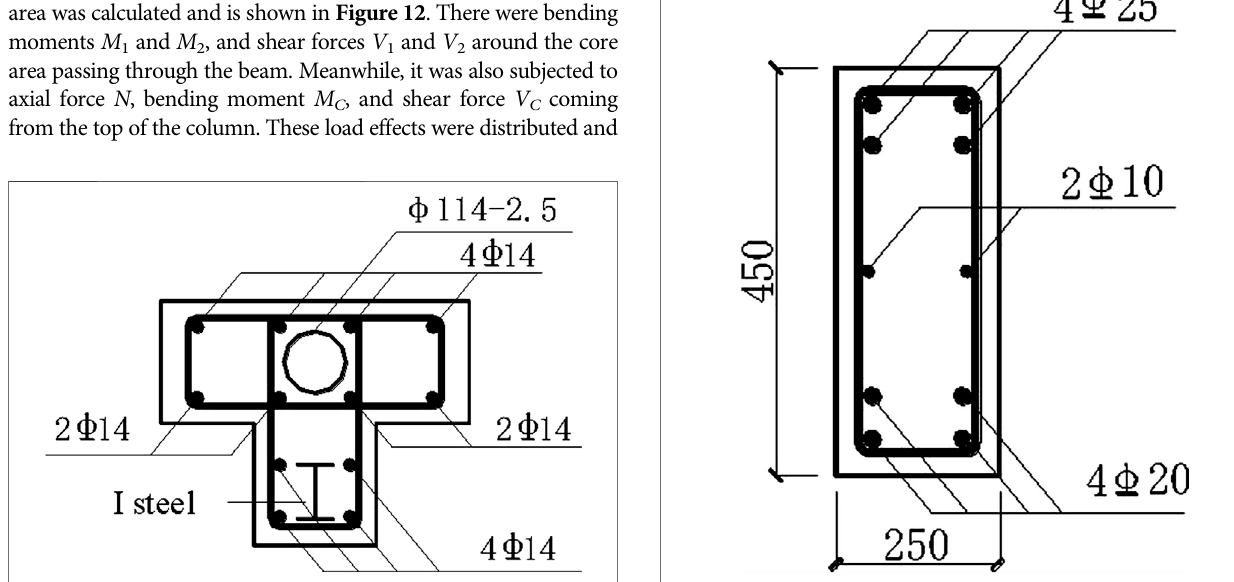
FIGURE 3 | Reinforcement of the column section of specimens JD-1, JD-2, and JD-3.